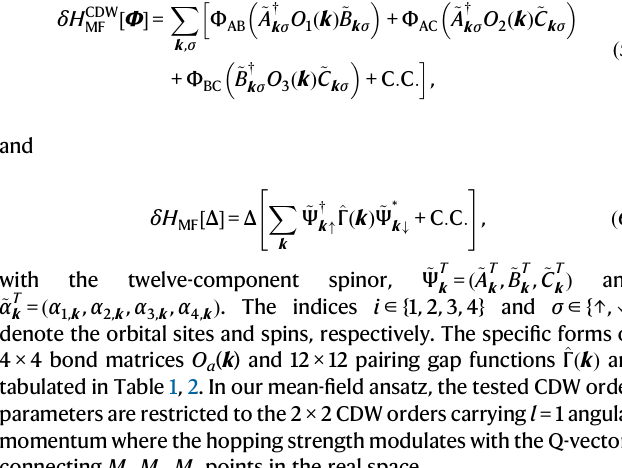
symmetry. In the 2× 2 unit cell, the mean- fi eld Hamiltonians for CDW